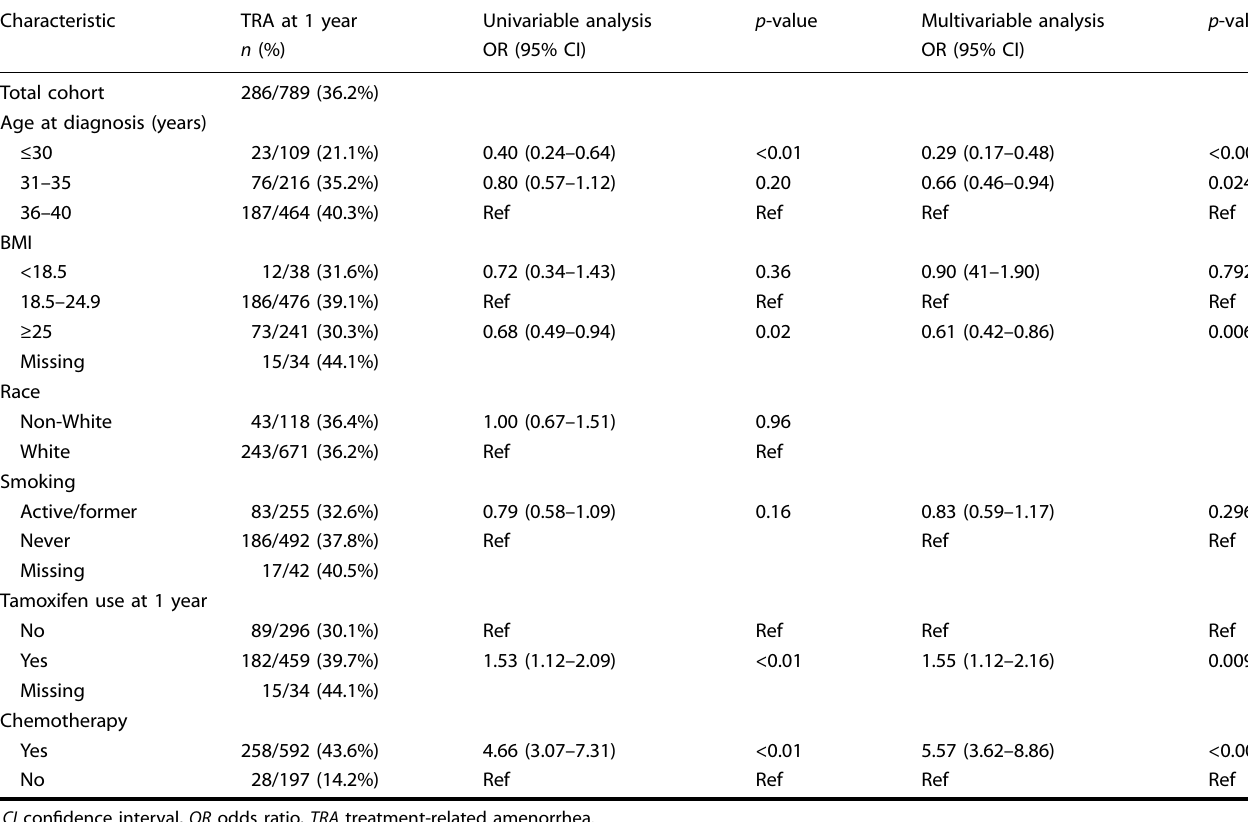
Table 2. Proportion of patients with 1-year TRA and associated characteristics among 789 eligible participants.